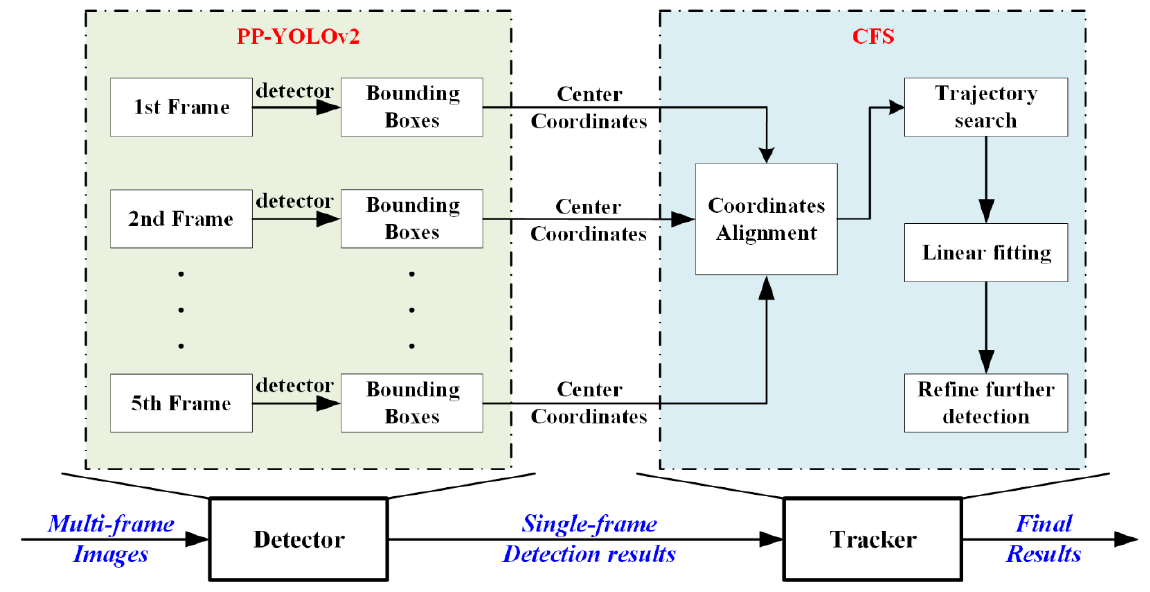
Figure 4. Flowchart of the proposed system.